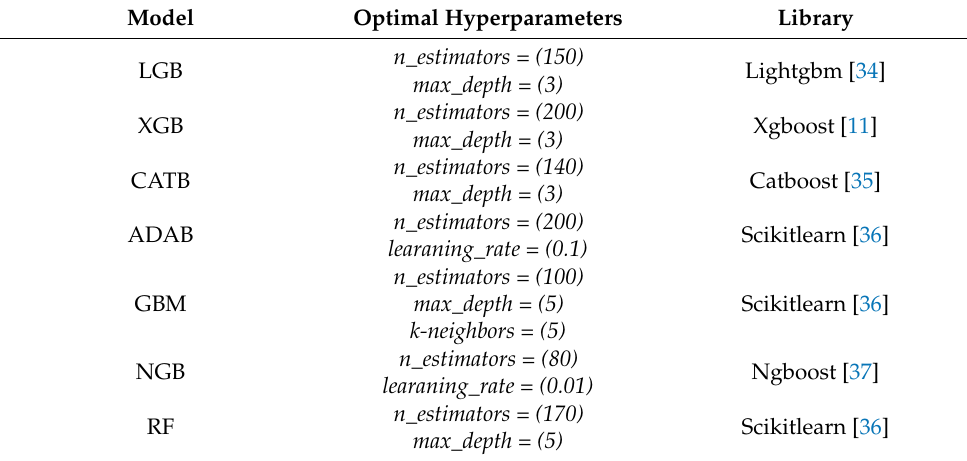
Table 1. Optimal hyperparameters for building various ML models.